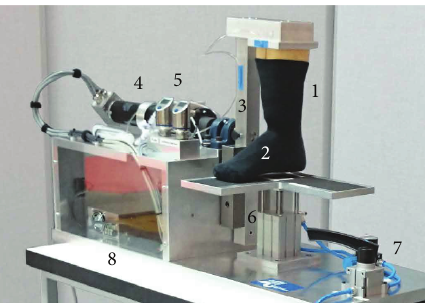
Figure 1: Setup of the fast testing method (FTM) in the flex- ion/extension position including (1) the wooden shank, with the shank air pad, (2) the last with the instep air pads, (3) the moving arm to apply the torque, (4) the motor, (5) the pressure sensors, (6) the pneumatic cylinder to apply the axial load with the valve (7), and (8) the electronics. The lower limb (1 and 2) is rotated by 90 degrees for inversion and eversion